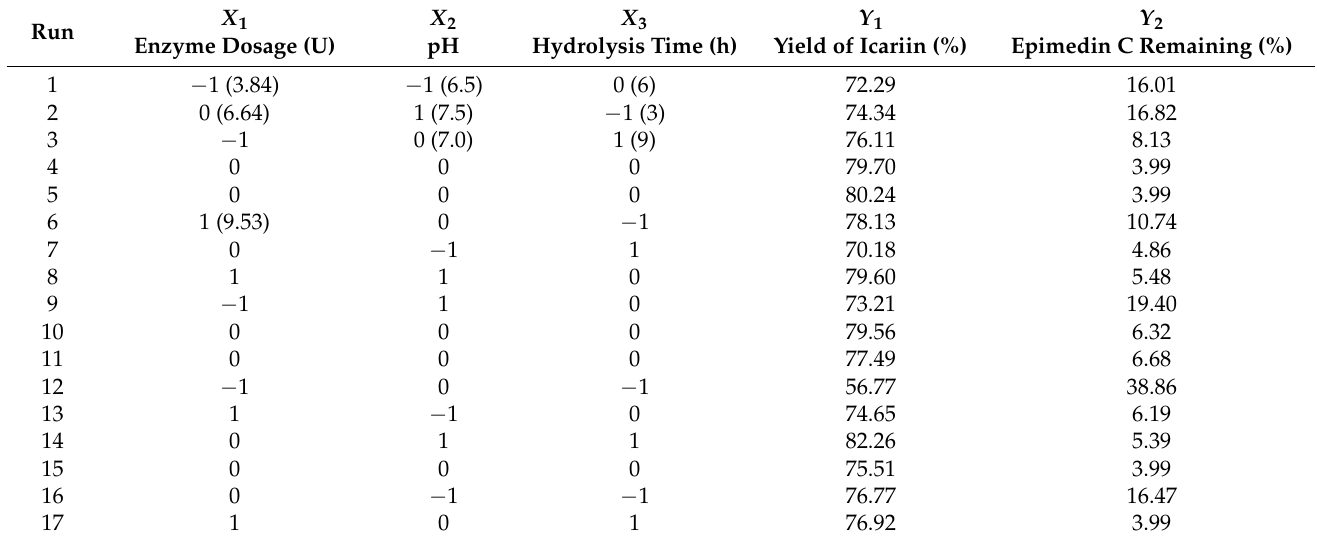
Table 1. Box–Behnken design matrix for optimization of the yield of icariin